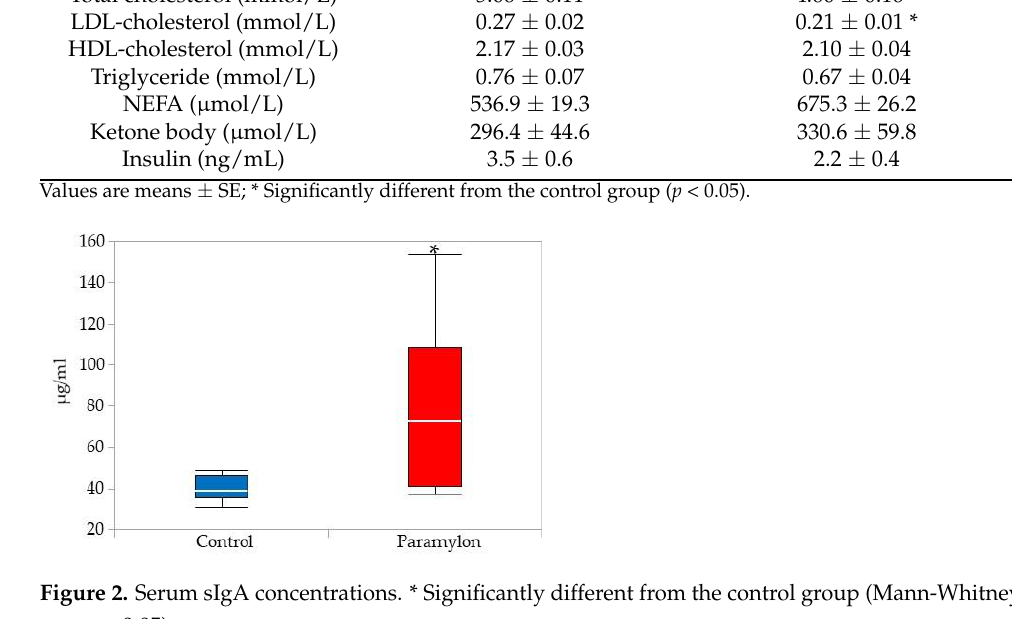
Figure 1. Blood glucose levels from the OGTT. Error bars represent standard error ( n = 10). * Blood glucose levels were significantly lower at 15 min and 120 min in the PM group when compared with the control group ( p < 0.05).